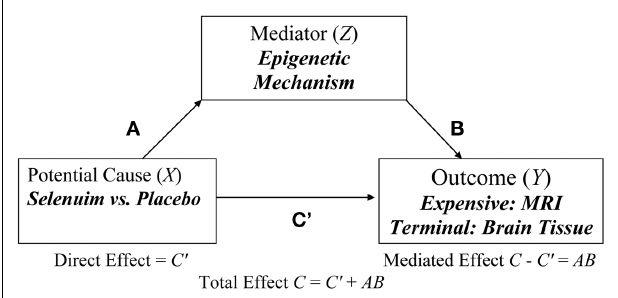
FIGURE 1 | Hypothetical example of an epigenetic mechanism ( Z ) mediating the effect of selenium ( X ) on an expensive (MRI) or terminal (brain tissue) outcome ( Y